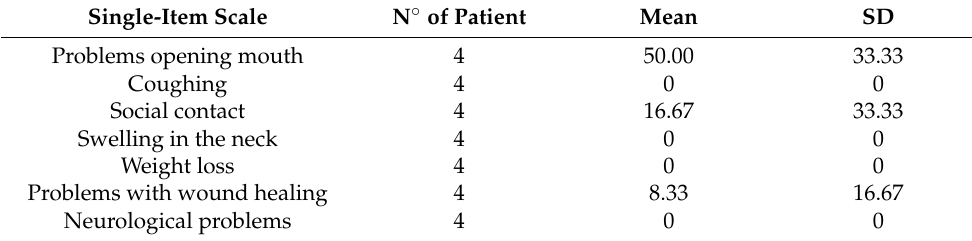
Table 5. No significant problems have been highlighted in the other domains. Table 5. Single-item score distributions for EORTC QLQ-H&N